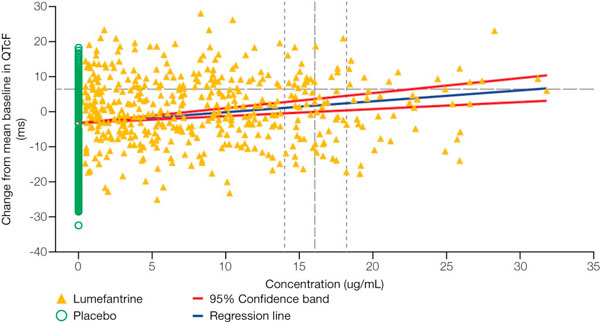
Relationship between QTc (Fridericia's formula) and maximum plasma concentration (Cmax) in healthy volunteers. [Data on file (study A2101), Novartis]. Note: the threshold of relevance for QTc change is 10 msec vs. placebo.